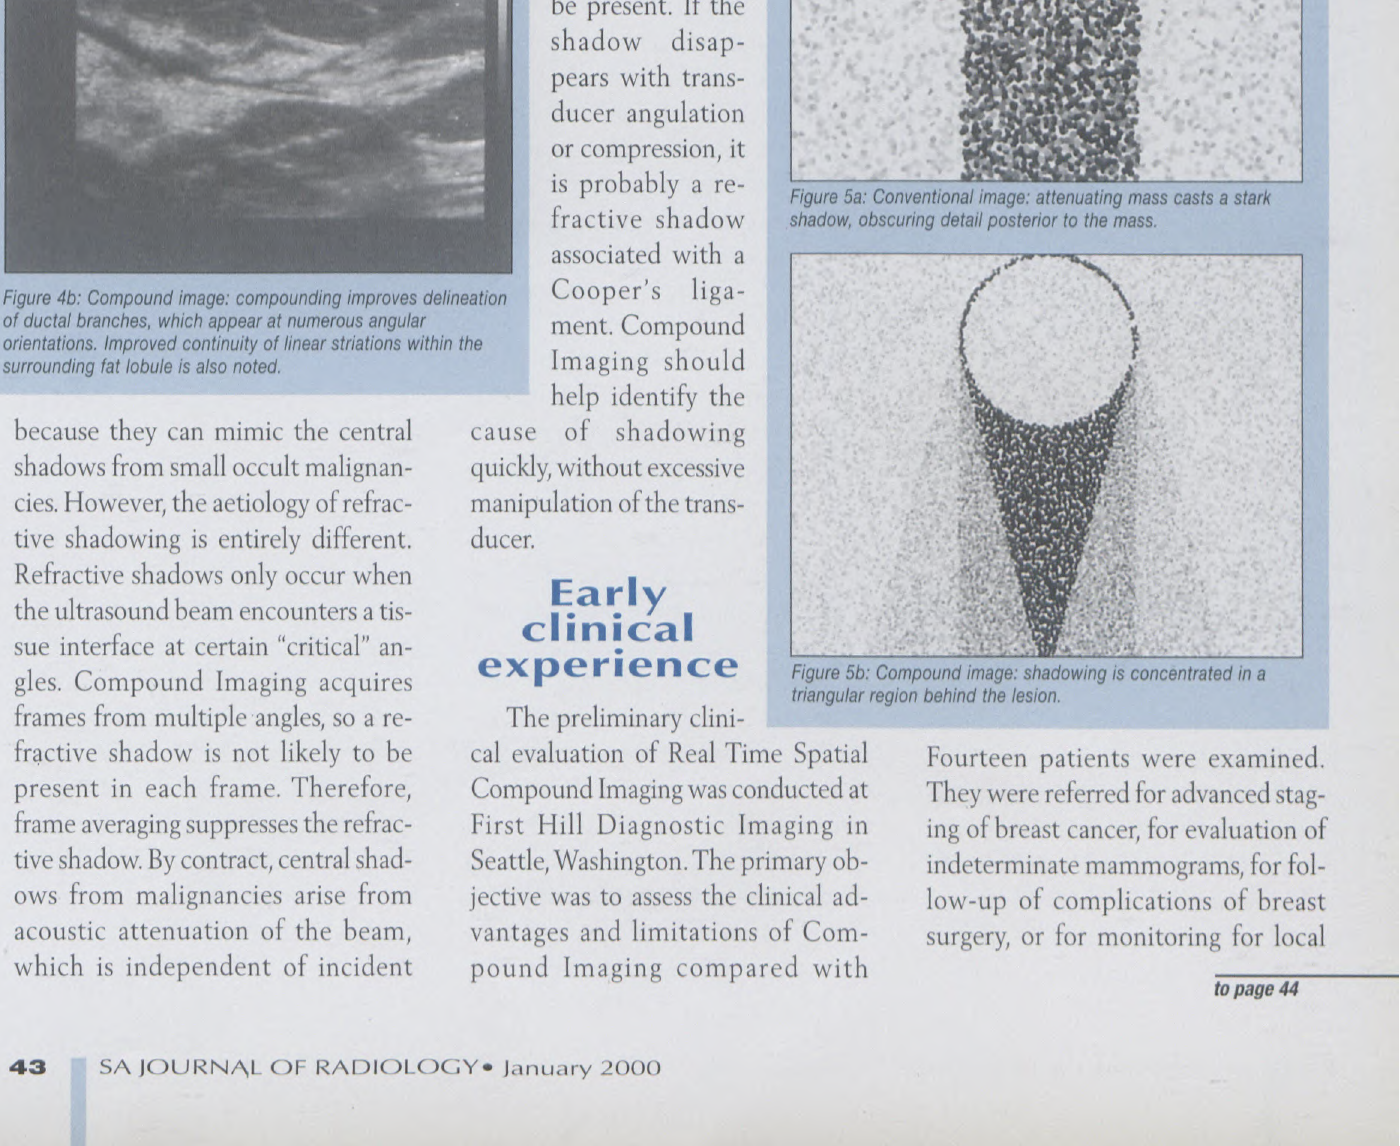
Figure 5a: Conventional image: attenuating mass casts a stark shadow, obscuring detail posterior to the mass.